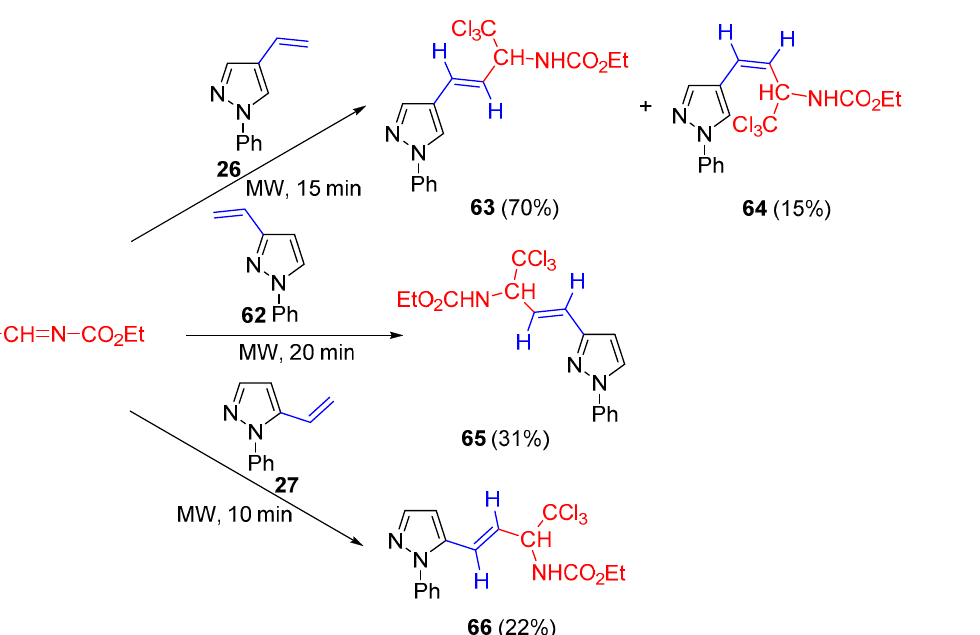
Scheme 25. Reactions of 1-phenylvinylpyrazoles 26 , 62 , and 27 with ethyl N -trichloroethylidenecar- bamate